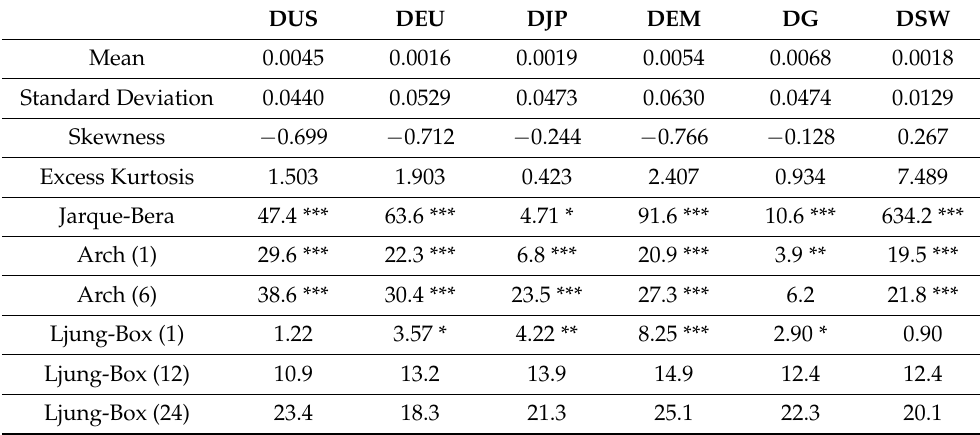
Table 1. Descriptive Statistics for Asset Returns. Monthly Data: 1999M2–2021M7 (270 Obs.).